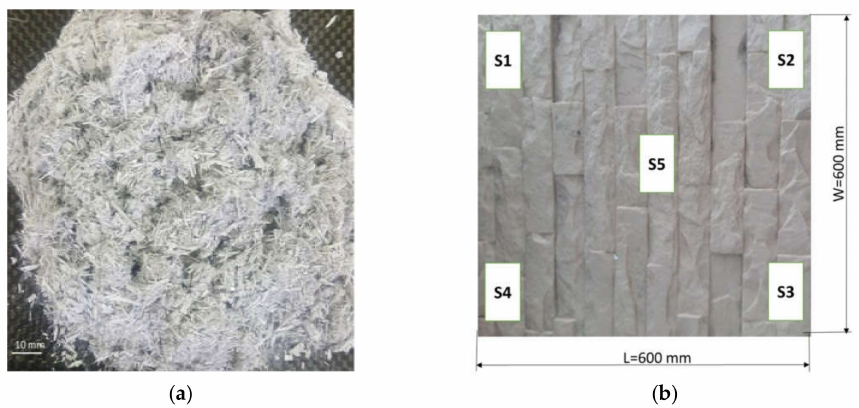
Figure 2. ( a ) Resultant glass fiber waste from the grinding process. ( b ) Scheme stating material sampling positions taken from the